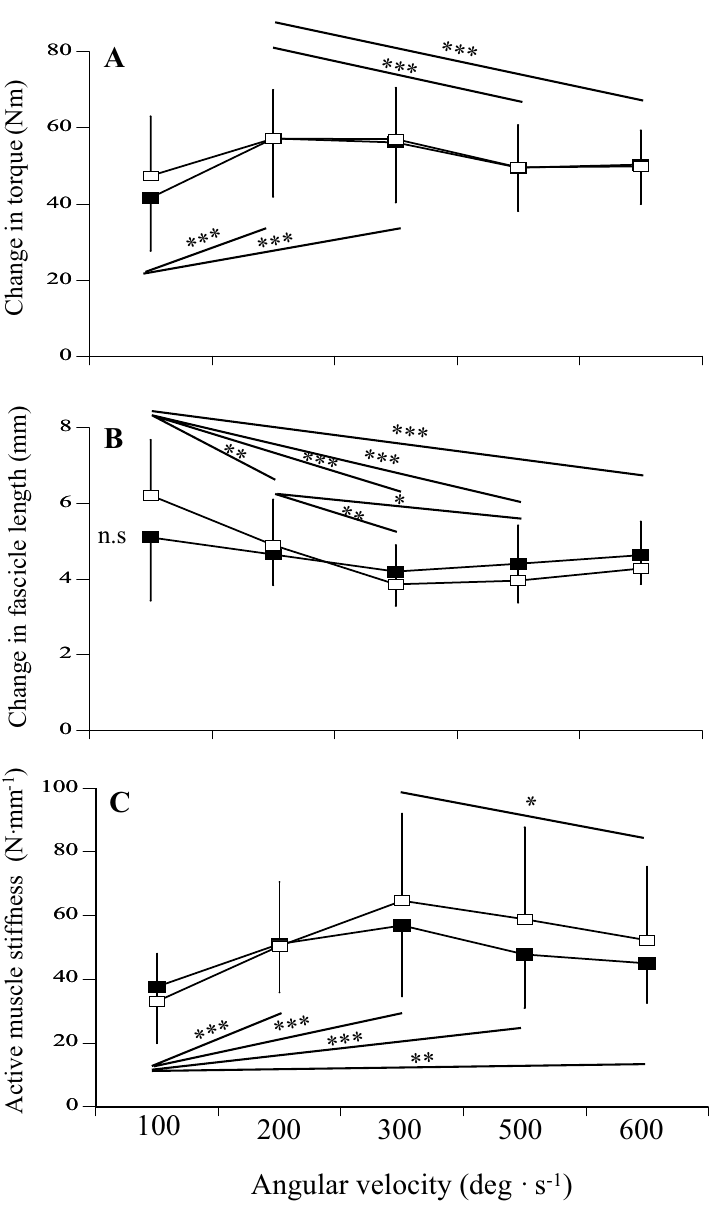
Figure 2. Changes in torque ( A ) and fascicle length ( B ), and active muscle stiffness ( C ) at 100, 200, 300, 500, and 600 deg s −1 in middle-aged (closed) and young (open) men. Significant difference among the conditions: *p < 0.05, **p < 0.01, ***p <